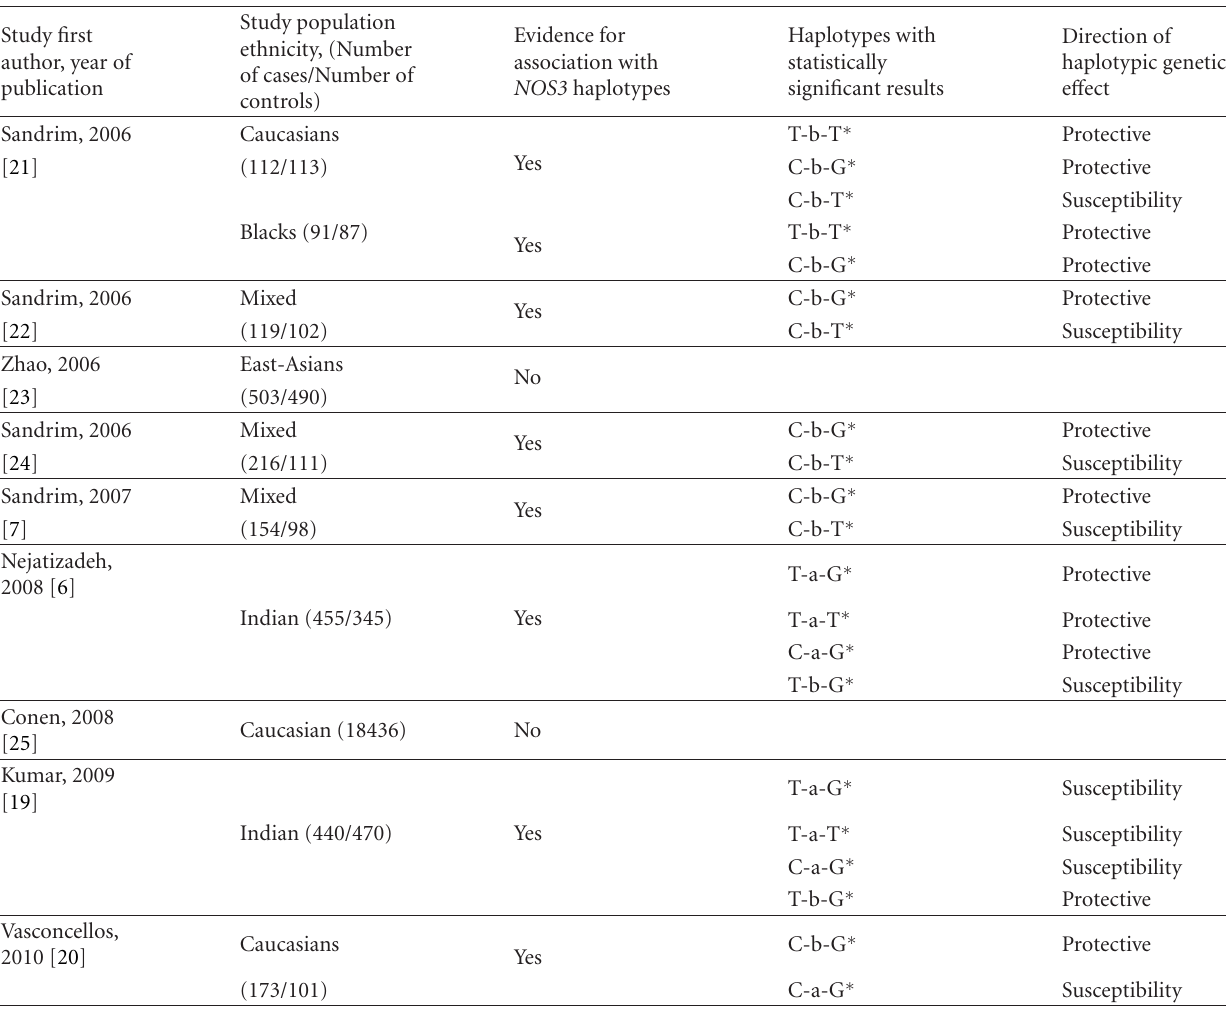
Table 6: Summary description of previous studies on the association between NOS3 haplotypes and essential hypertension. Study